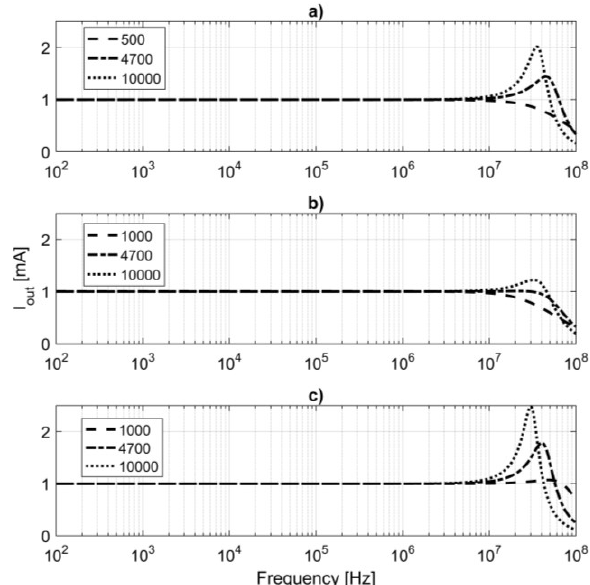
Fig.10: Simulated output current when the value of R 3 is changed. The value of R 3 in ohms is showed at the legends, the load was 1 kΩ. a) QUAD b) DIF_C c) DIF_M.